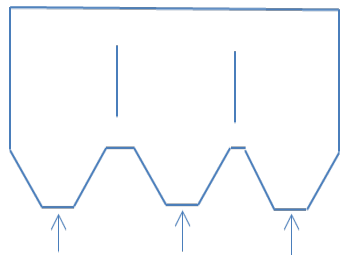
Figure 10. Example of assembly of multiple units.